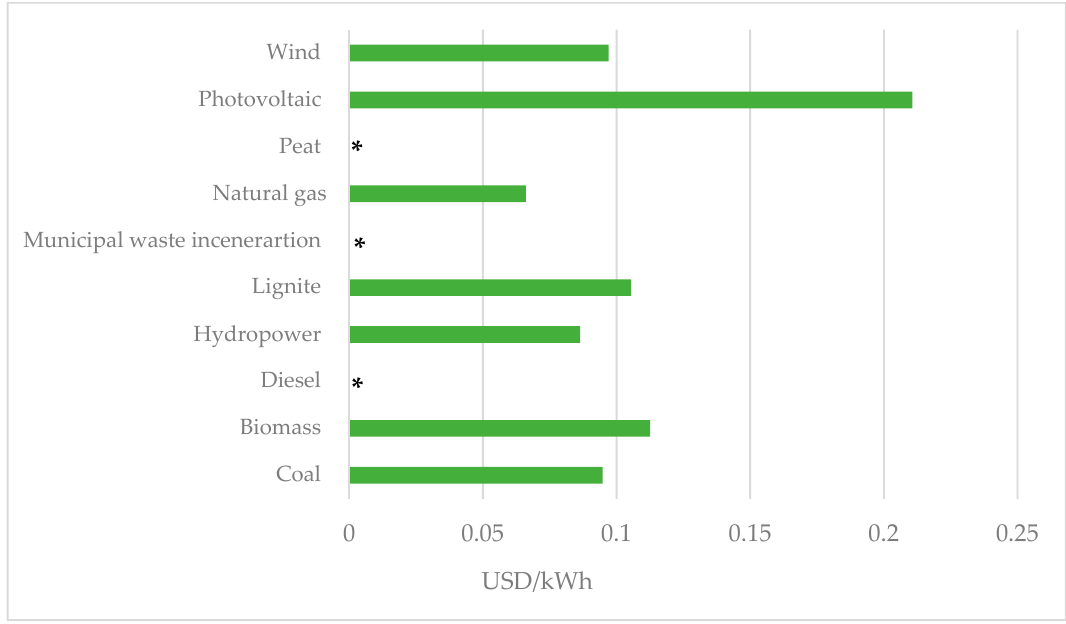
Figure 3. Costs analysis of electricity sources examined (* data not found).